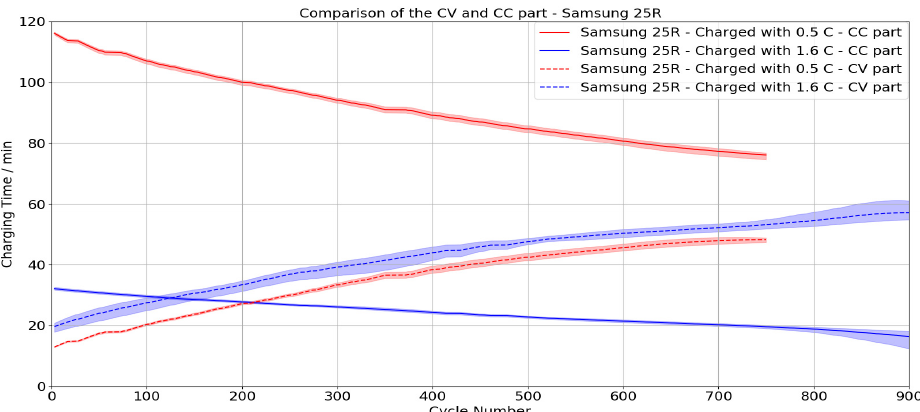
part for Samsung 35E.